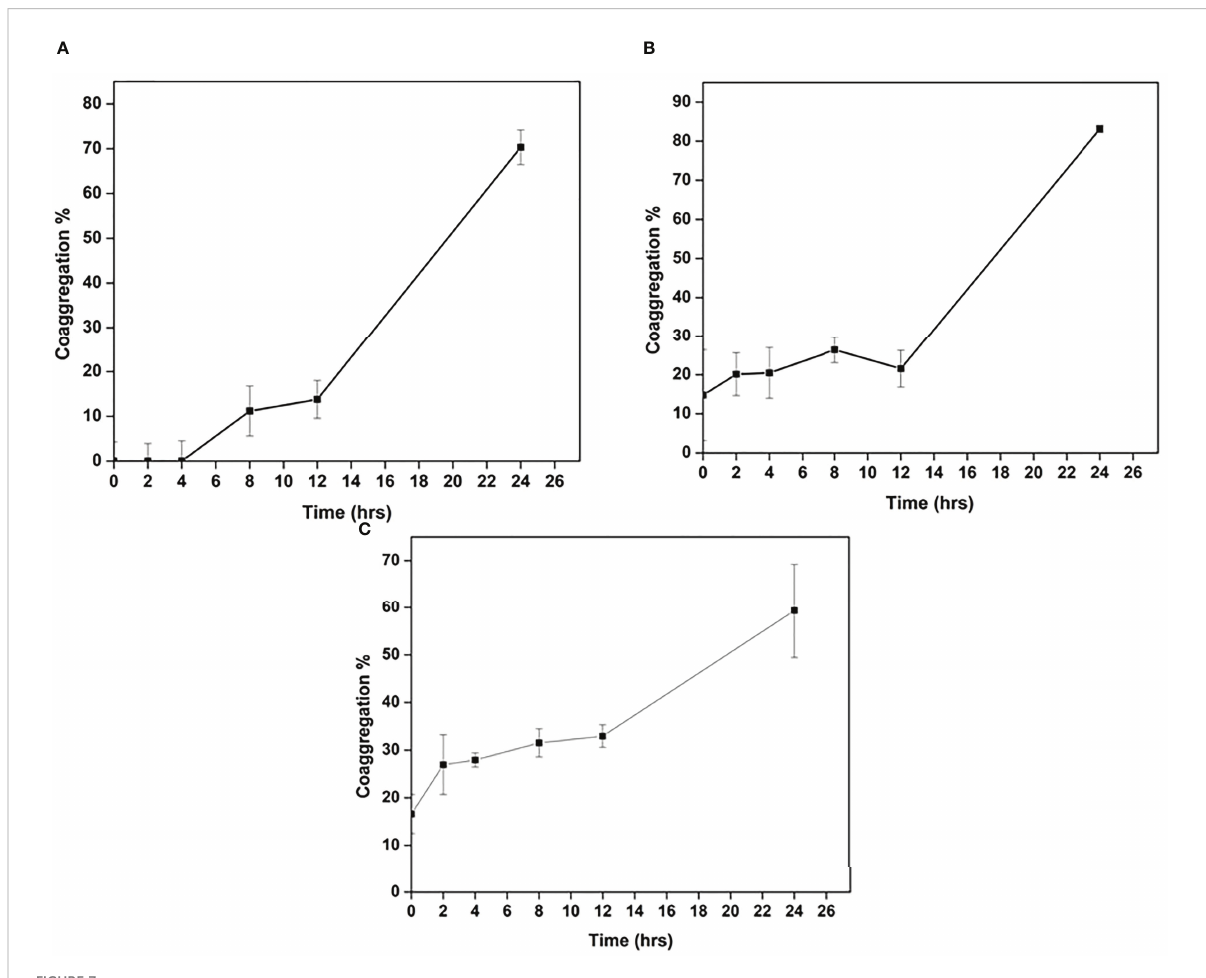
FIGURE 7 Co-aggregation of Cellulomonas sp. HM71 with Salmonella typhimurium (A) , Staphylococcus aureus (B) , and. E.coli (C)